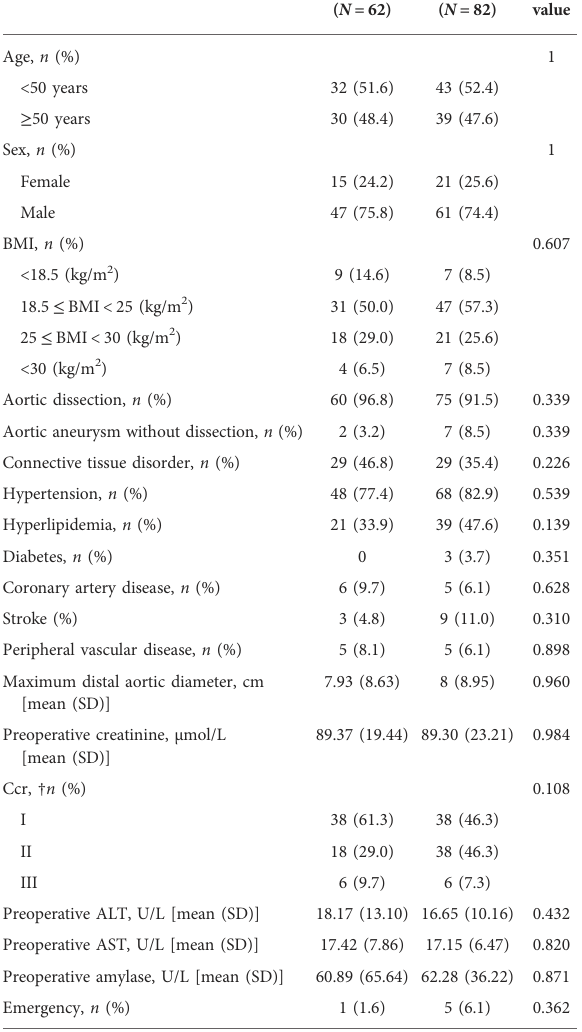
TABLE 1 Patient